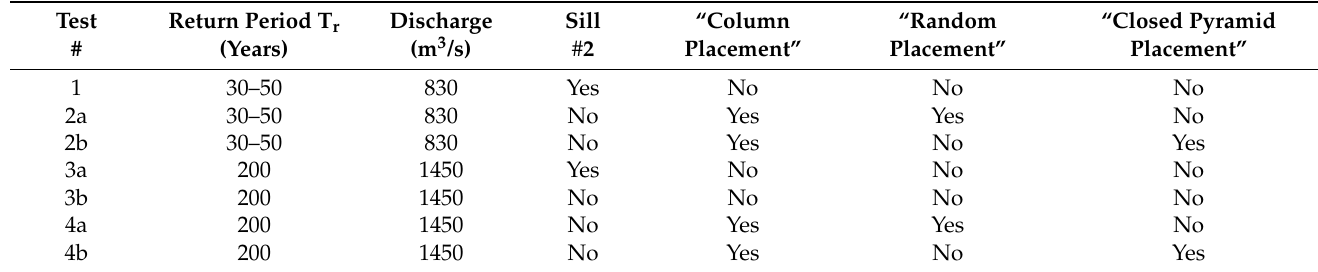
Table 1. Experimental test.